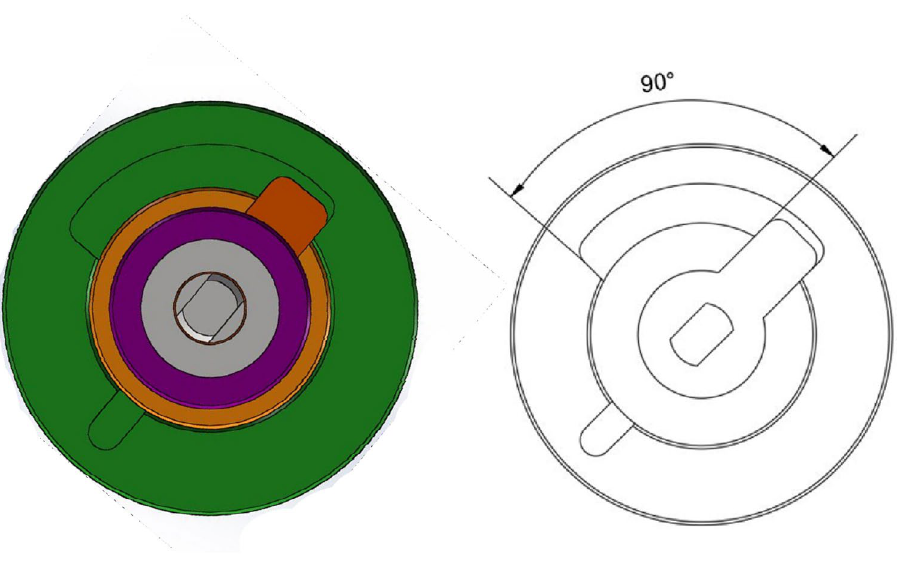
Figure 4. Working section of rotary